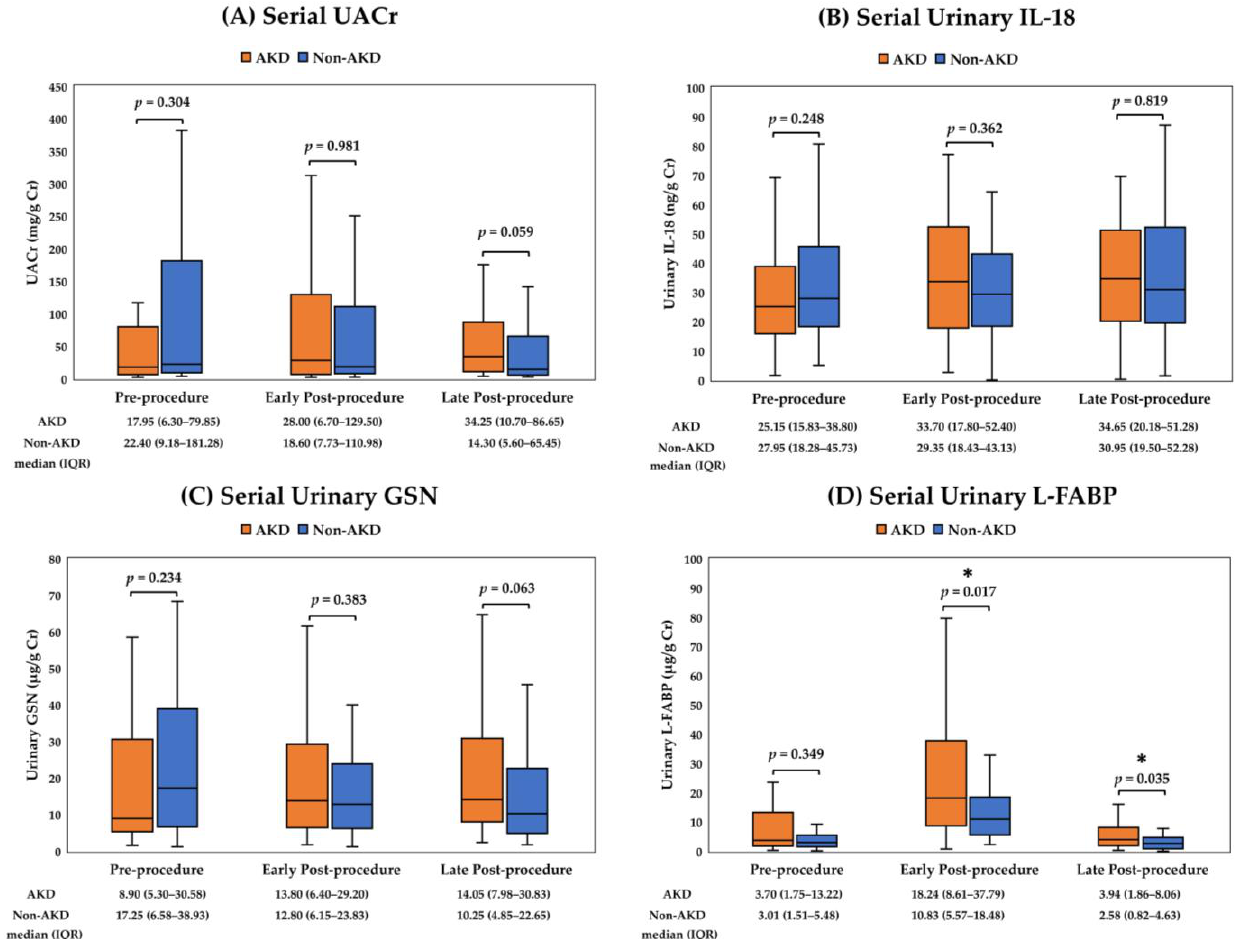
Figure 2. Comparisons of Serial Urinary Biomarkers between Groups. ( A ) Serial UACr; ( B ) serial urinary IL-18; ( C ) serial urinary GSN; ( D ) serial urinary L-FABP. AKD, acute kidney disease. * p < 0.05.